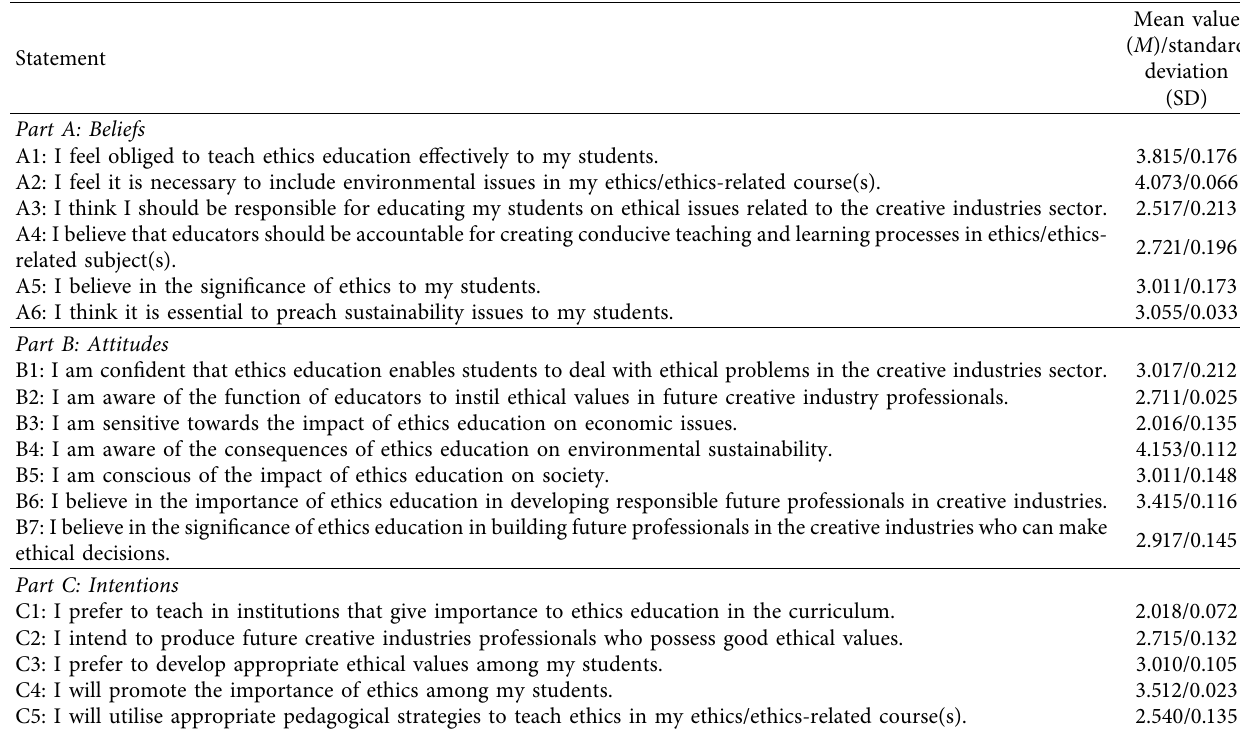
Table 1: Mean values and standard deviations for parts A, B, and C of the questionnaire.